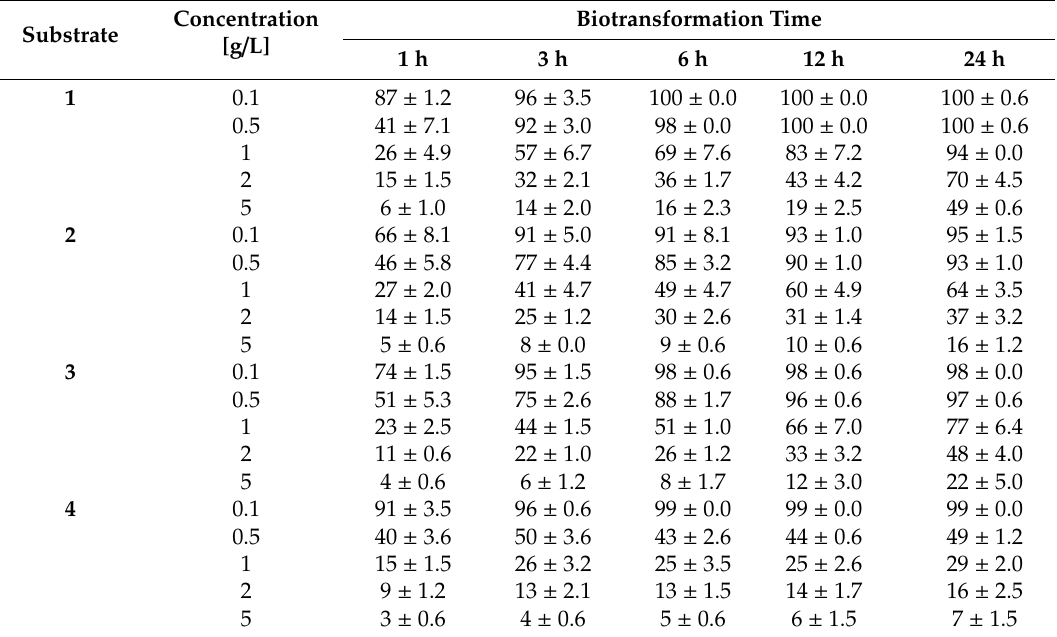
Table 3. Conversion of selected substrates depending on their concentration and biotransformation time, performed in triplicate.